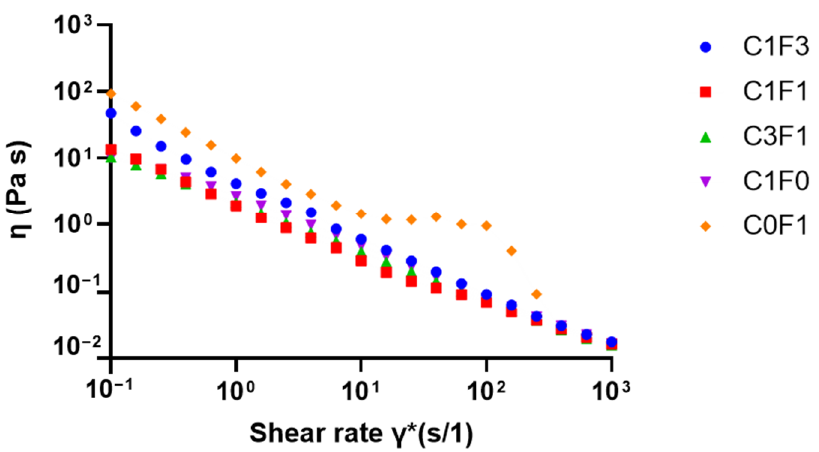
Figure 6. Viscosity as a function of shear rate for solutions with varying ratios between CNC and CNF before polymerization.